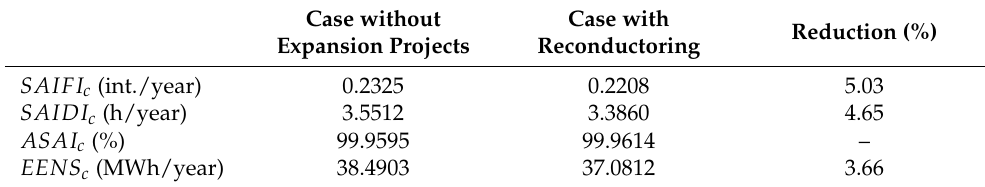
Table 8. Impact of reconductoring on reliability indices.